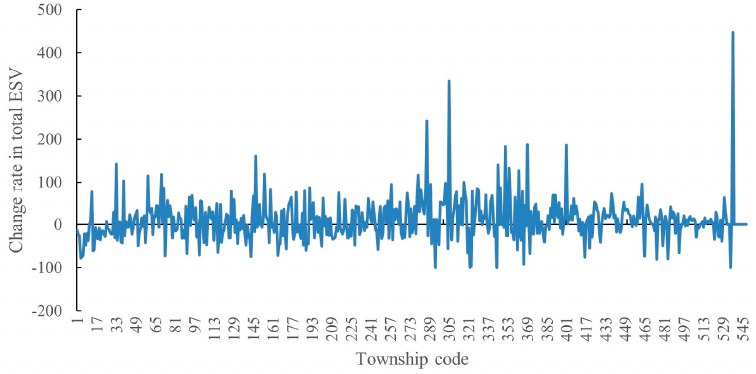
Figure 5. Change rate of total ESV of study area at township scale from 2015 to 2020.